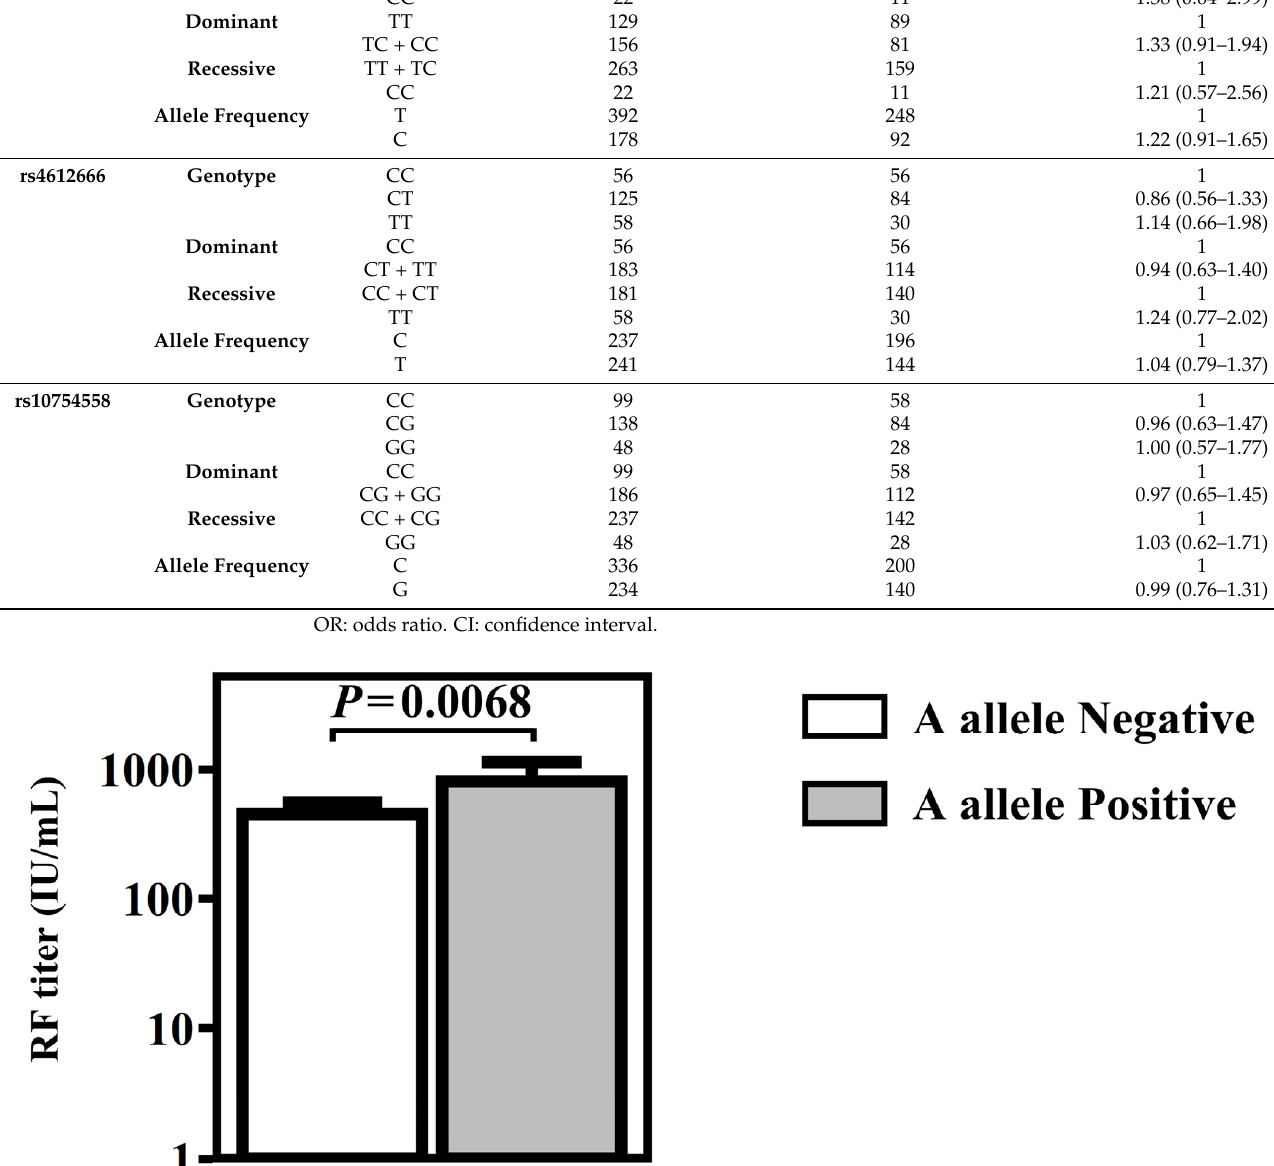
Figure 1. Associations of rs12079994 G/A polymorphisms with titer of rheumatoid factor.